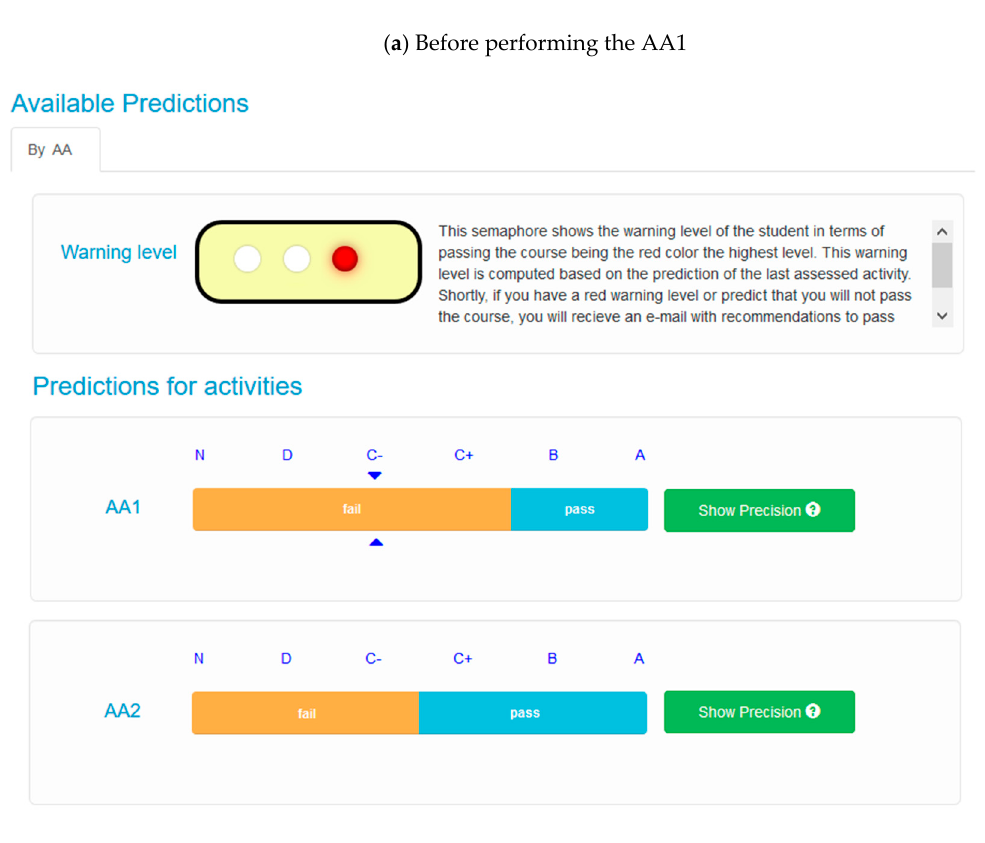
Figure 5. Early warning dashboard for students.